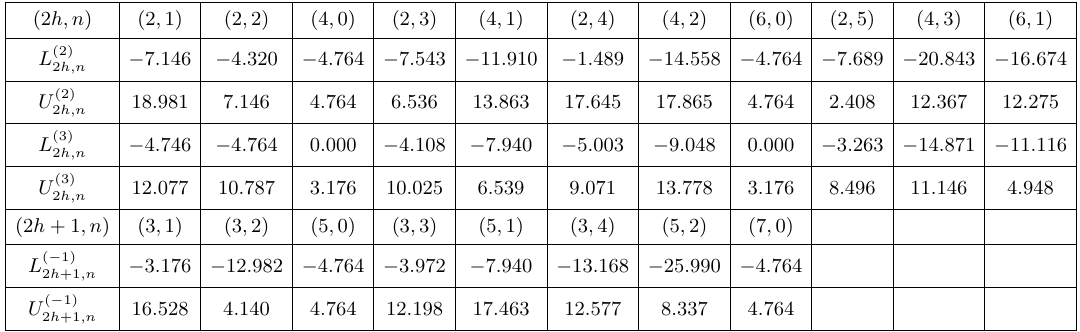
, c 2 h,n and c 2 h +1 ,n , for which we are agnostic about all the (2) (3) ( − 1) and U ( a ) are defined in eq. (4.17). We use the m,n m,n